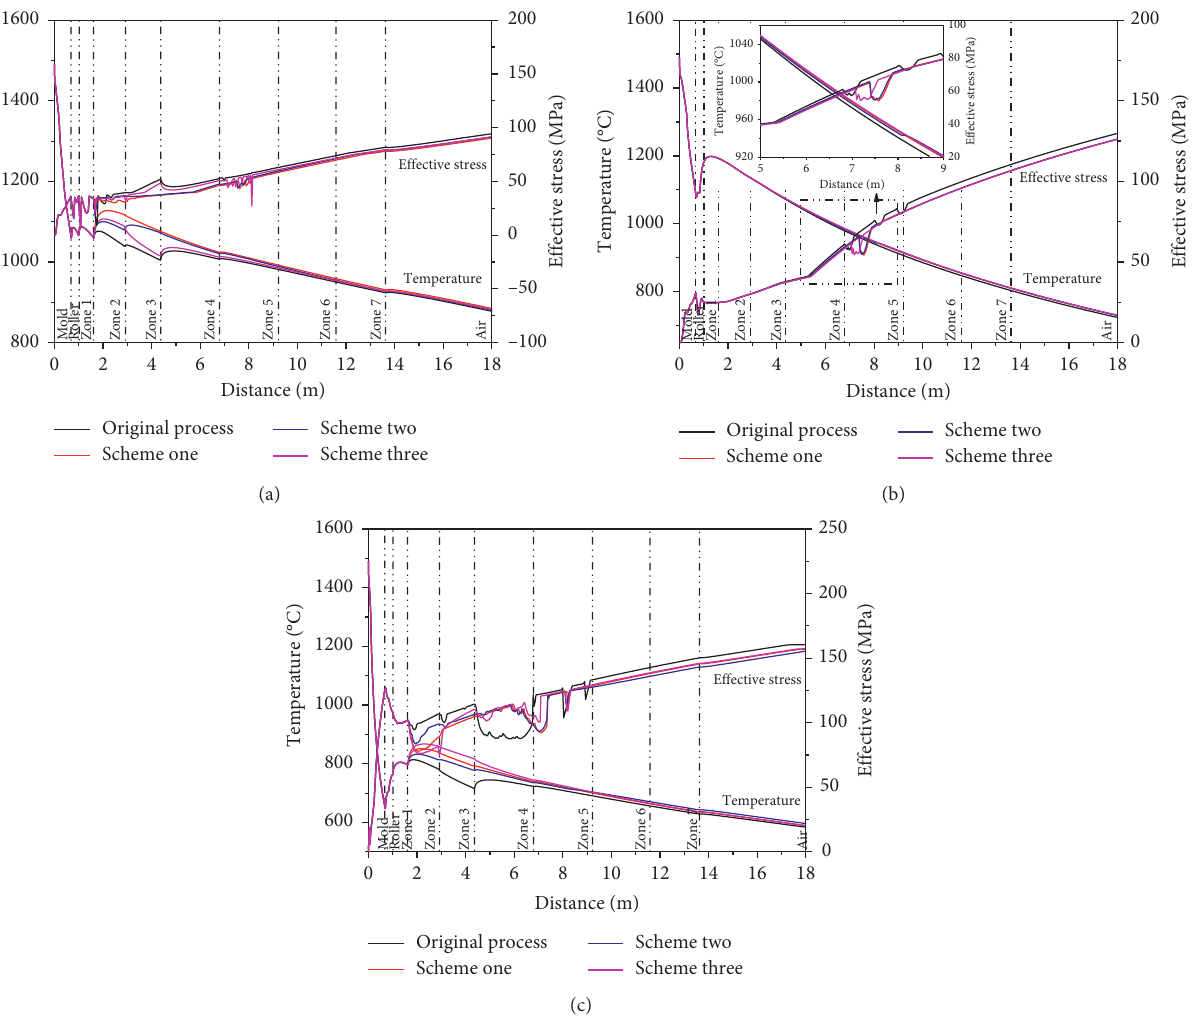
Figure 14: The curves of temperature and effective stress under different water distribution schemes. (a) Wide surface center. (b) Narrow surface center. (c)